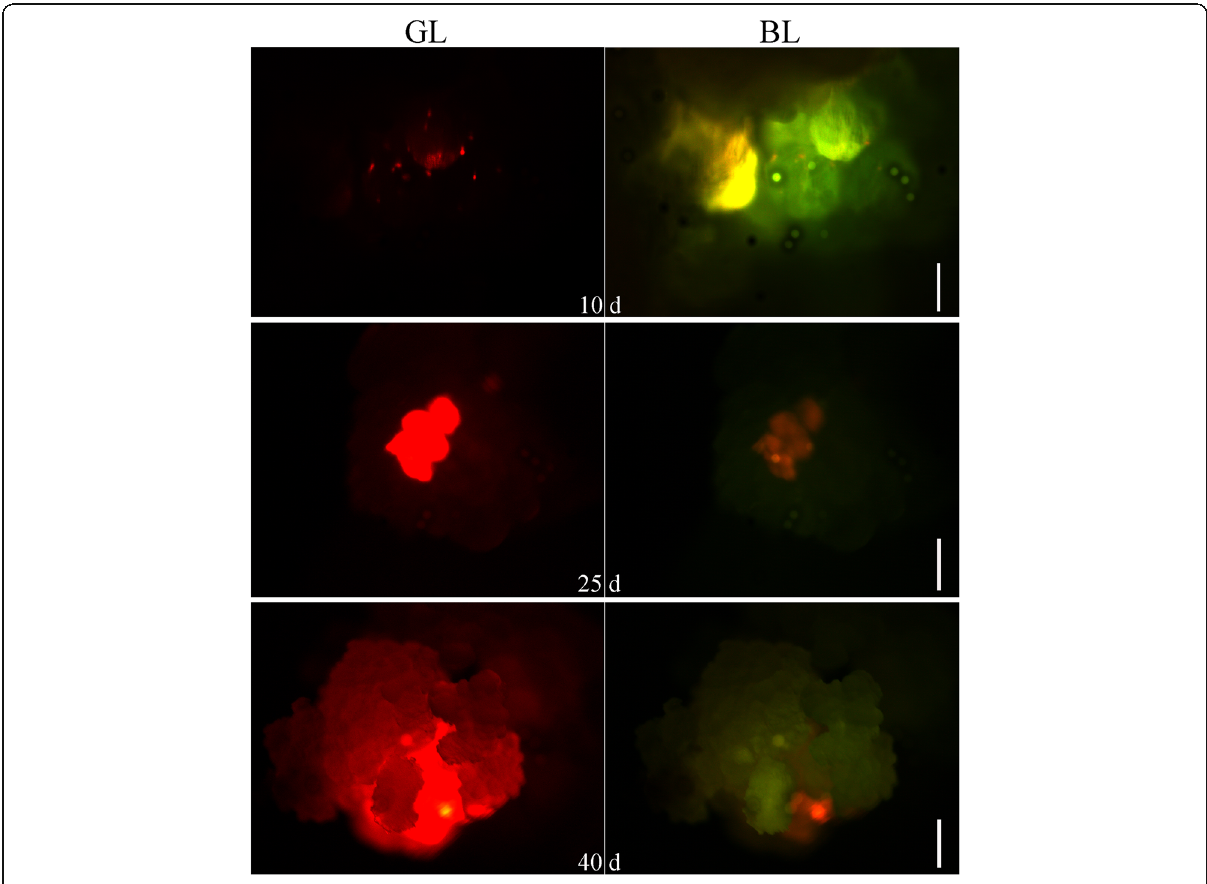
Fig. 2 Transgenic callus after different incubation periods under a green light and blue light, respectively. Green light (GL) and blue light (BL). (Scale bars, 1.0